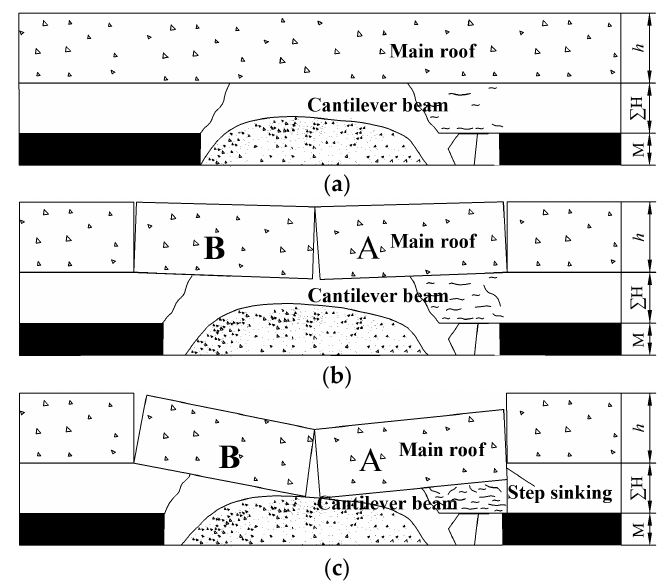
Figure 7. The structure of the main roof before and after the first weighting: ( a ) before breaking, ( b ) before instability, ( c ) roof step sinking.